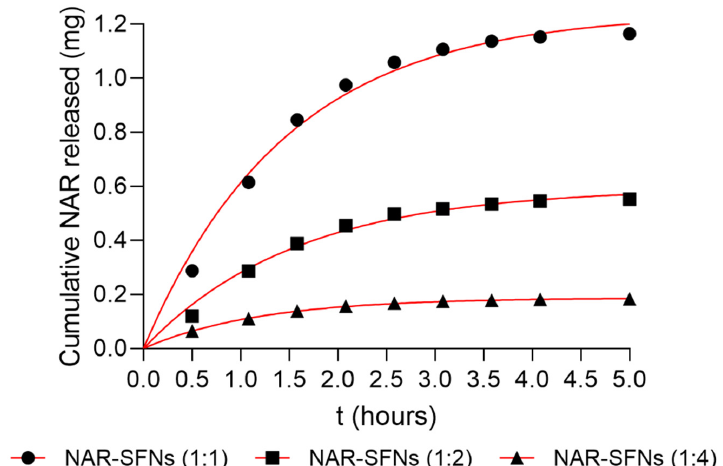
Figure 7. Cumulative mass of NAR released as a function of incubation time in PBS 1x (pH = 7.4) containing 0.5% of Tween 80 at 37 °C. The symbols represent experimental values. Continuous lines represent the best fit with first order equation.